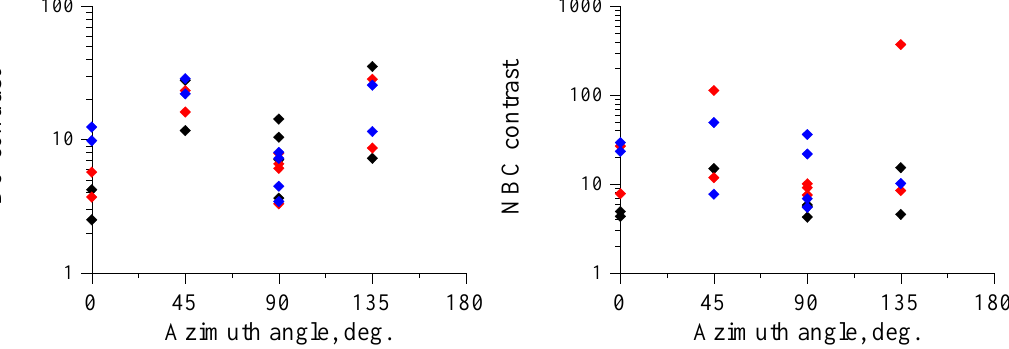
Azimuth angle, deg. Figure 7. BC ( left panel ) and NBC ( right panel ) contrasts vs. azimuth angle (0 ◦ —upwind, 90 ◦ — crosswind). GWR 19.08.2021. Black symbols—S-band, red—C-band, and blue—X-band. Wind velocity 5–6 m/s.